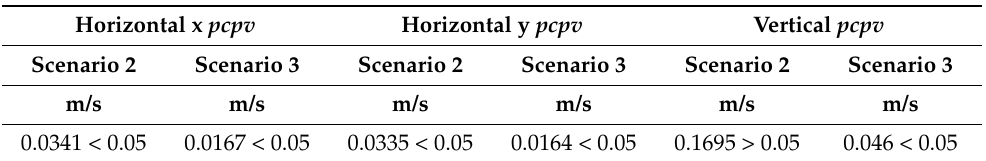
Table 4. Values of peak component particle velocity in the vertical direction ( pcpv 0 ) obtained in node 45 and comparison with the peak component particle velocity in the limit ( pcpv lim